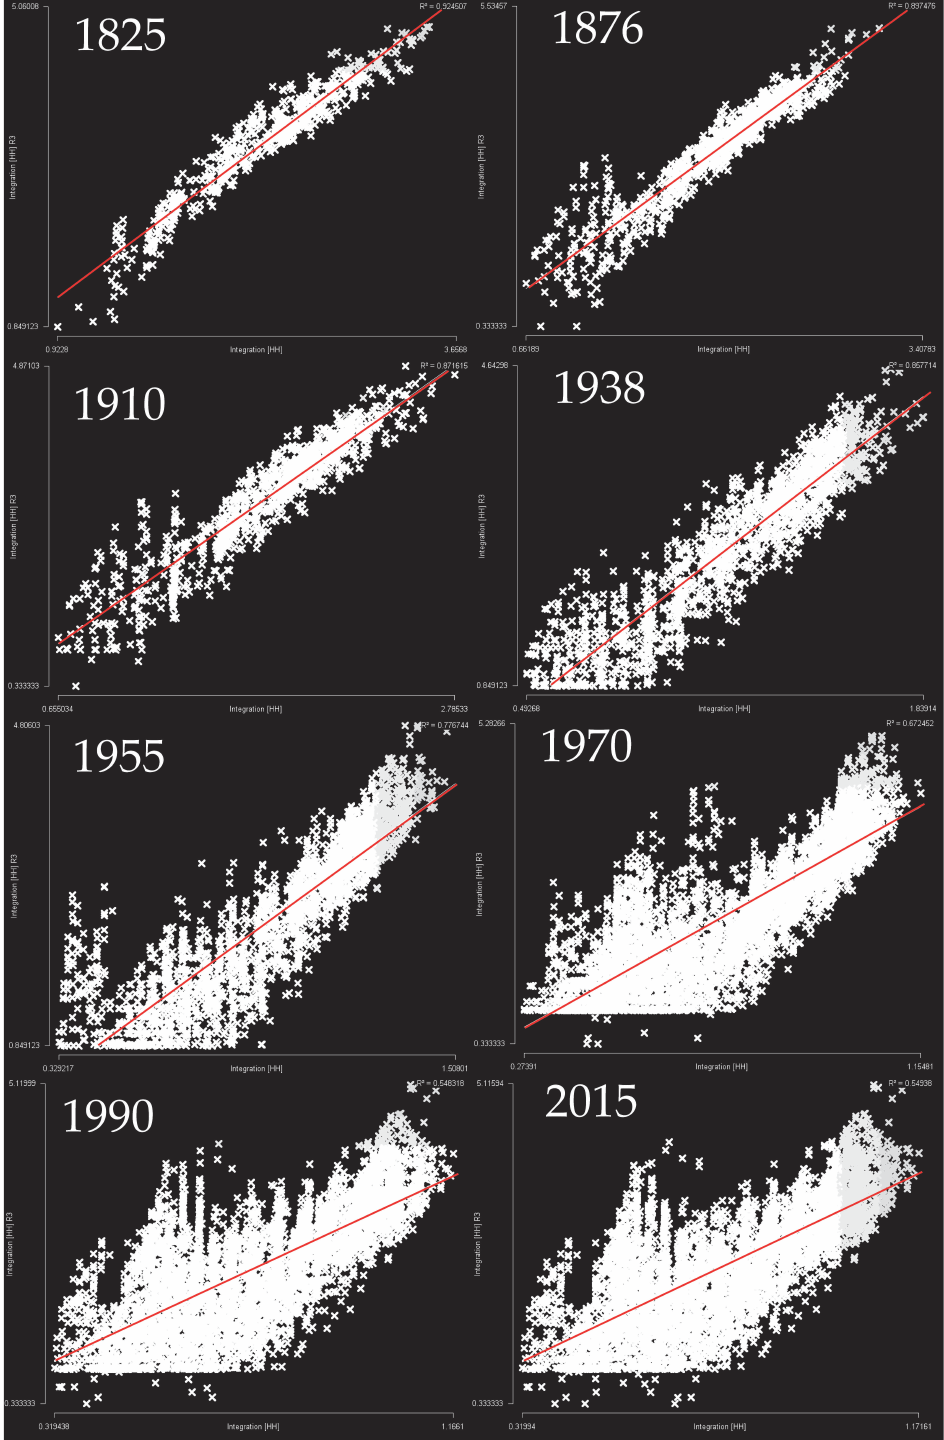
Figure 7. Correlation local ( R = 3) vs. global ( R = n) integration in Florence, 1825–2015. Global 1 integration values are on the x-axis; local integration values are on the